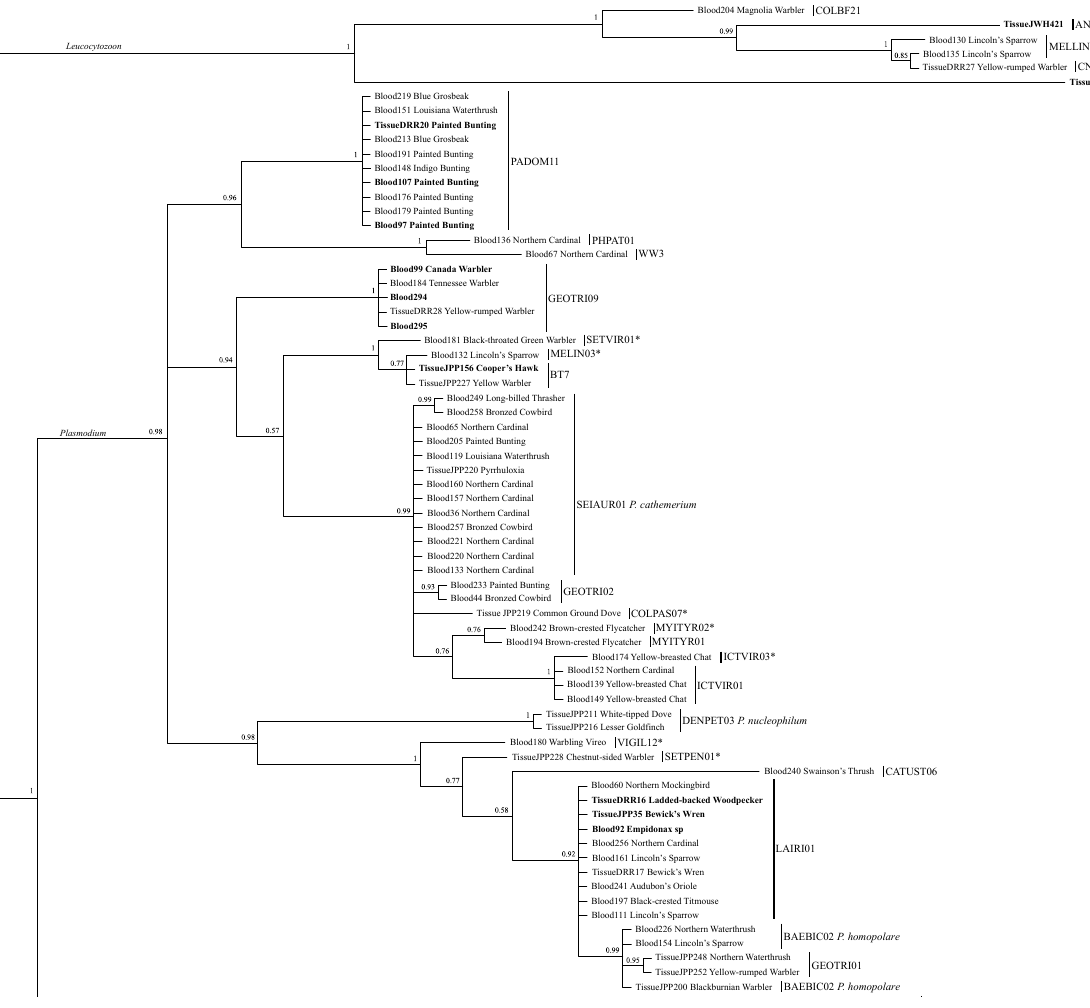
Figure 2. Bayesian analysis of all Leucocytozoon and Plasmodium sequences collected from blood and tissue in this study. Bold text indicates samples from SAV, and regular weight text refers to ES samples. Asterisks indicate sequence greater than 1 bp and 99% or less similarity with MalAvi closest match, and which were given new lineage designations.